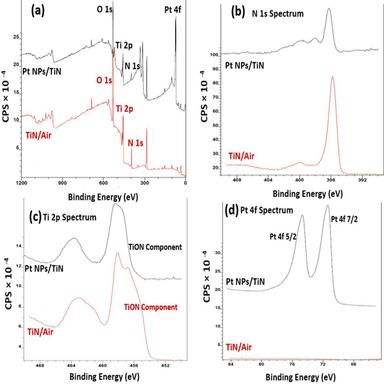
Broad spectrum XPS (a) TiN/Air and Pt NPs/TiN, high-resolution XPS spectra of (b) N 1 s, (c) Ti 2p, and (d) Pt 4f.